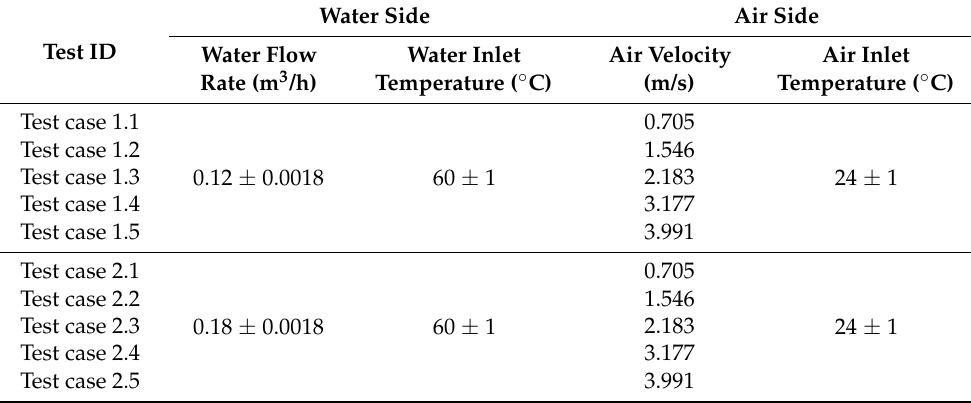
Table 1. Test matrix for the comparative steady-state tests